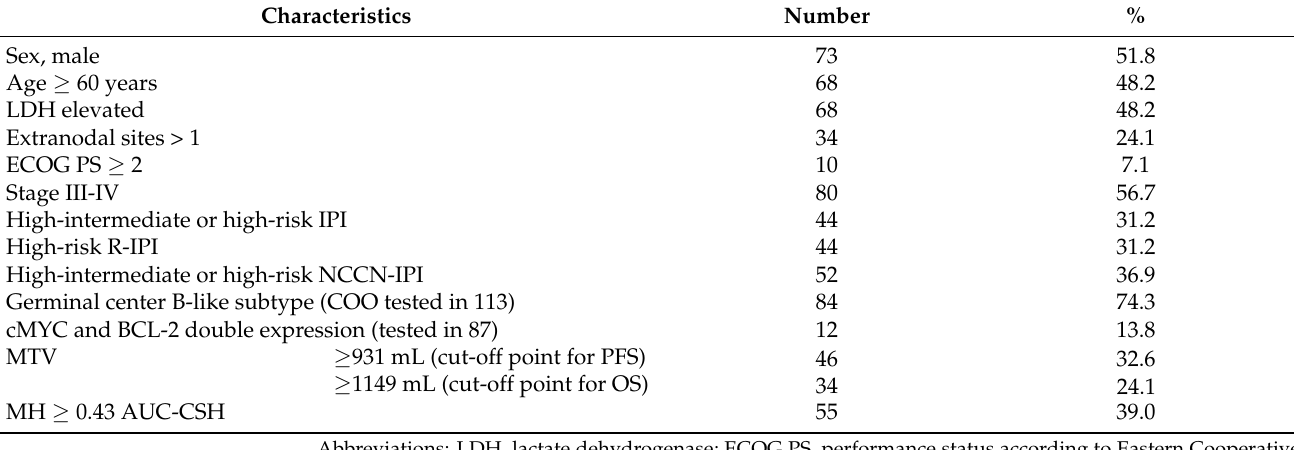
Table 1. Main features at baseline in the whole cohort of 141